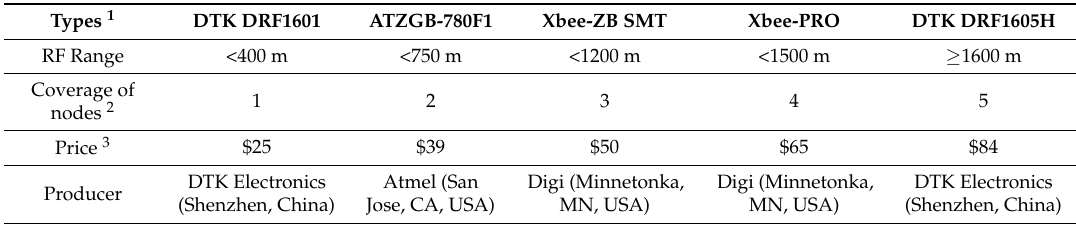
Table 3. Communication Range@ 2.4GHz and prices of sensor node devices.